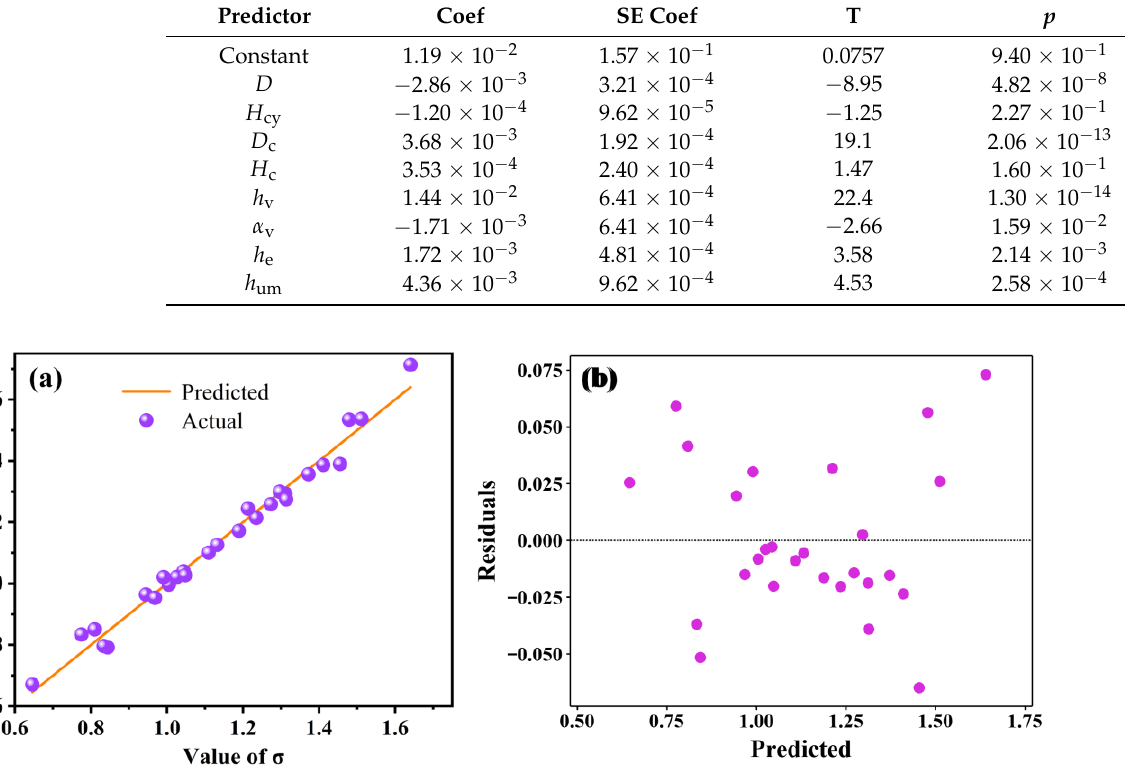
Figure 10. ( a ) The relationship between simulated response value and predicted value and ( b ) the relationship between residual and predicted value. Table 11. Regression analysis for factors on σ .